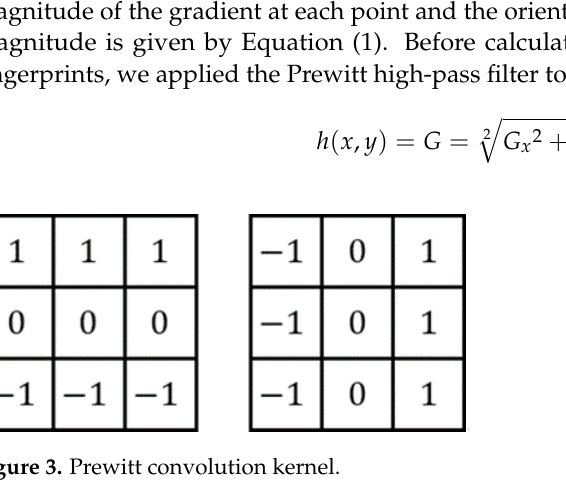
Figure 3. Prewitt convolution kernel.